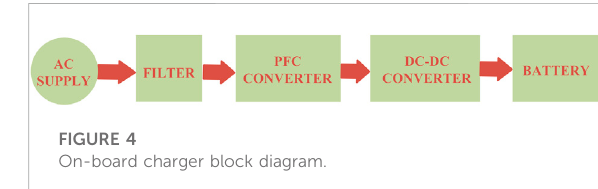
FIGURE 4 On-board charger block diagram.